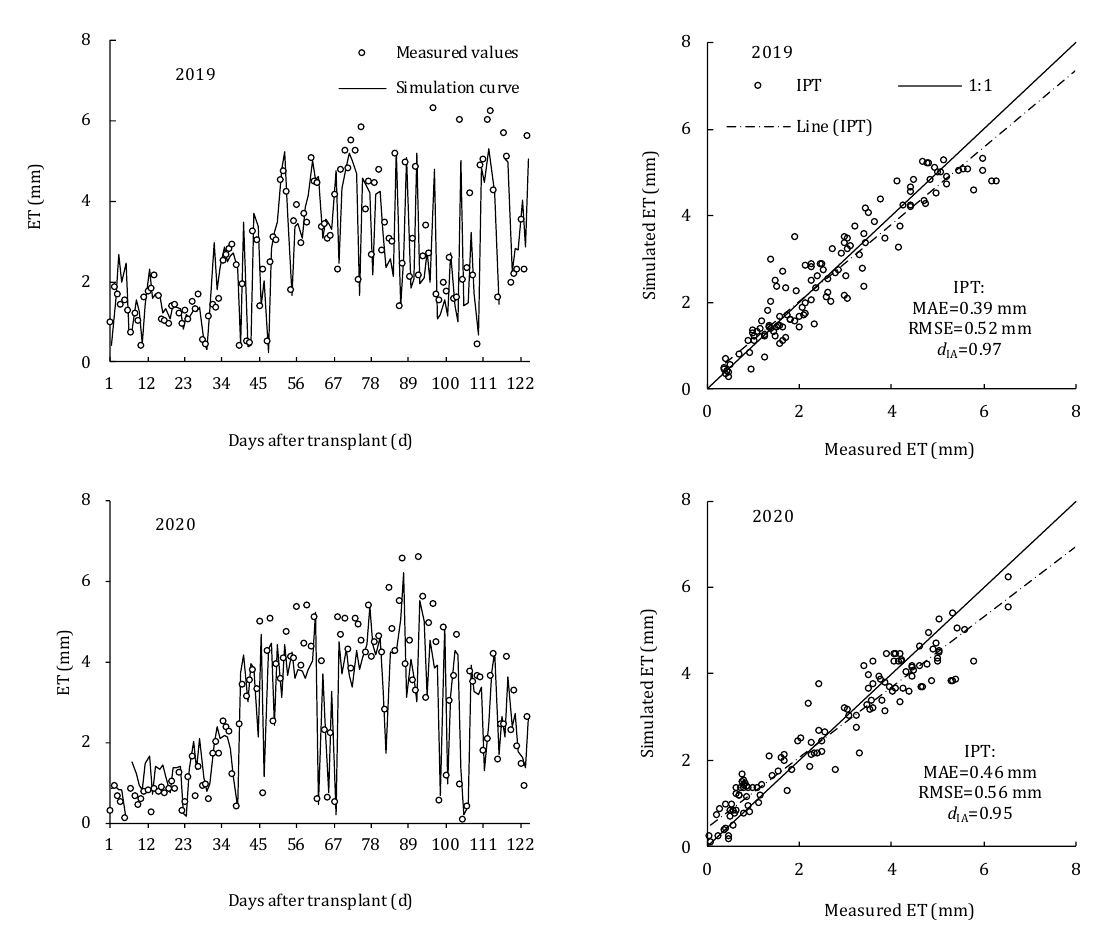
Figure 5. Comparison of measured and simulated daily ET of greenhouse tomato during the whole growth stage in 2019 and 2020.